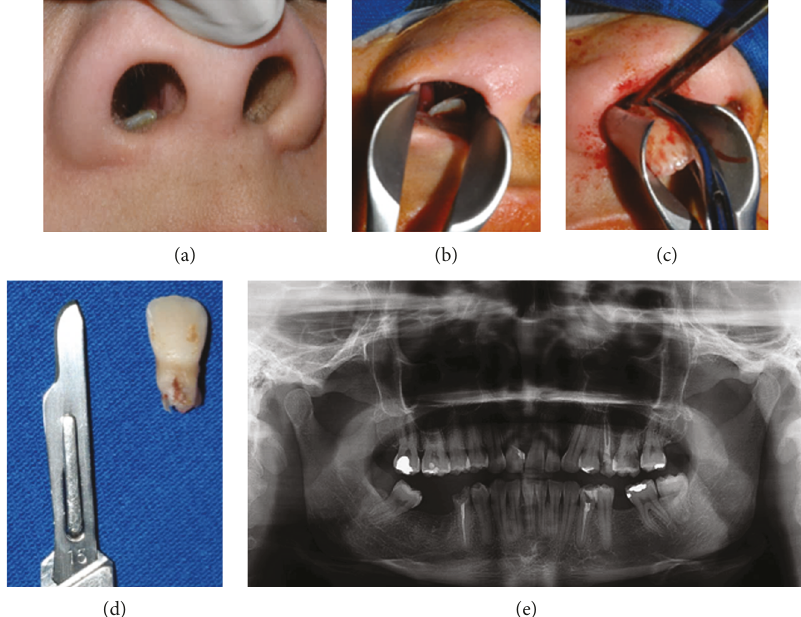
Figure 2: (a) Preoperative picture showing the exposition of the ectopic tooth inside the right nostril. (b, c) With the aid of nasal speculum, the tooth was removed by intranasal approach. (d) Tooth removed. (e) Panoramic radiograph con fi rms the complete removal of the element